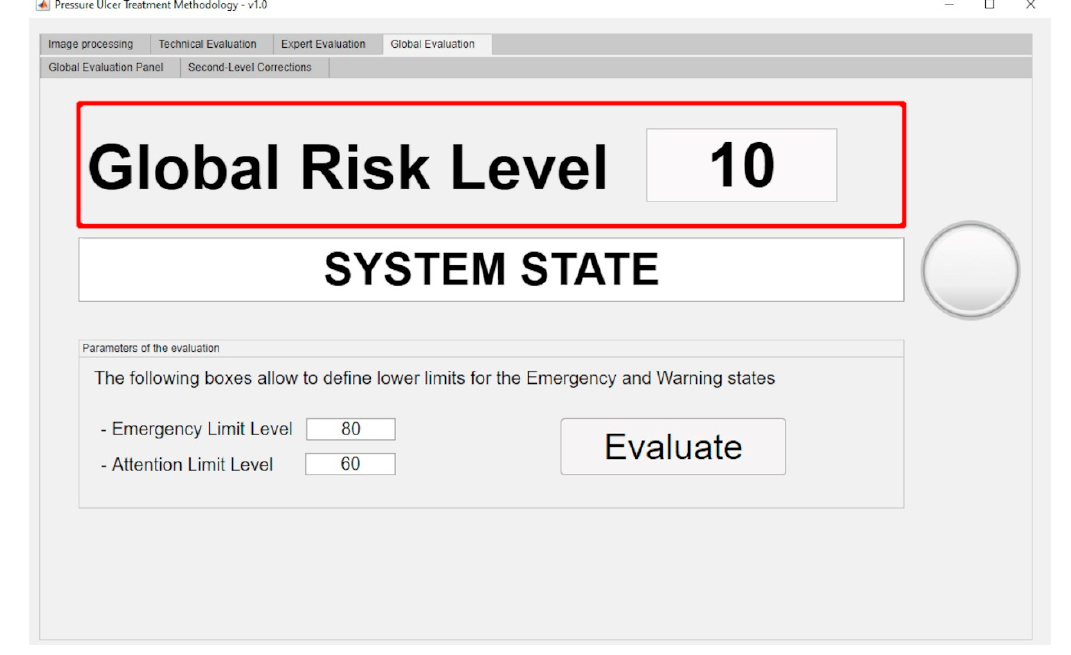
Figure 15. Global Risk calculation panel.